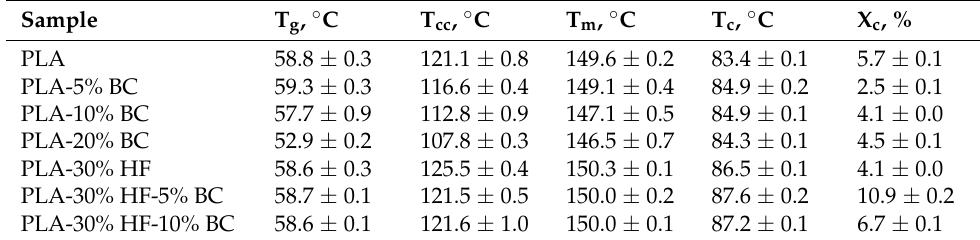
Table 6. DSC analysis results of PLA-based